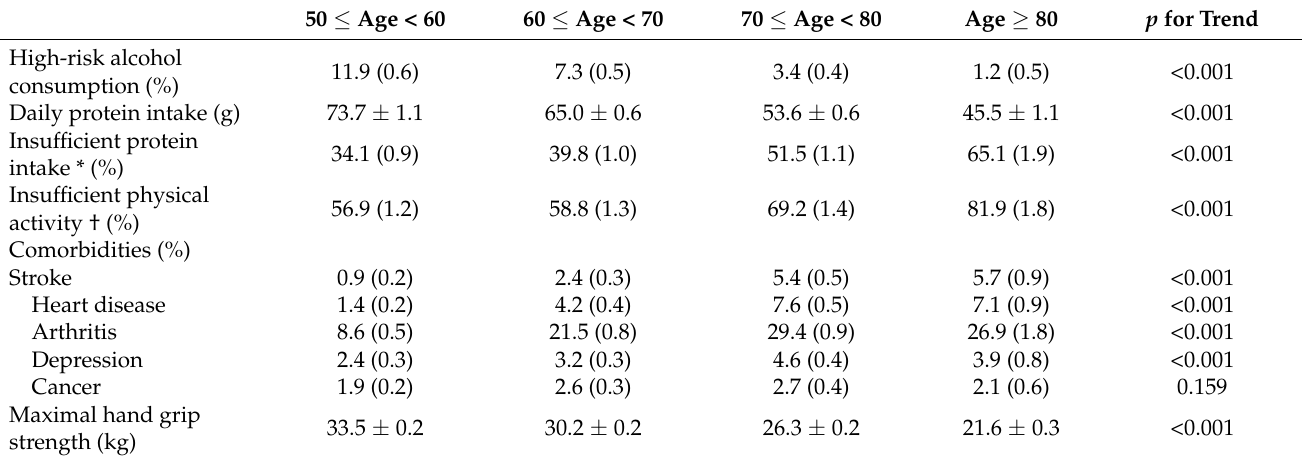
Table 2. Different characteristics that were related with functional disability according to age groups.